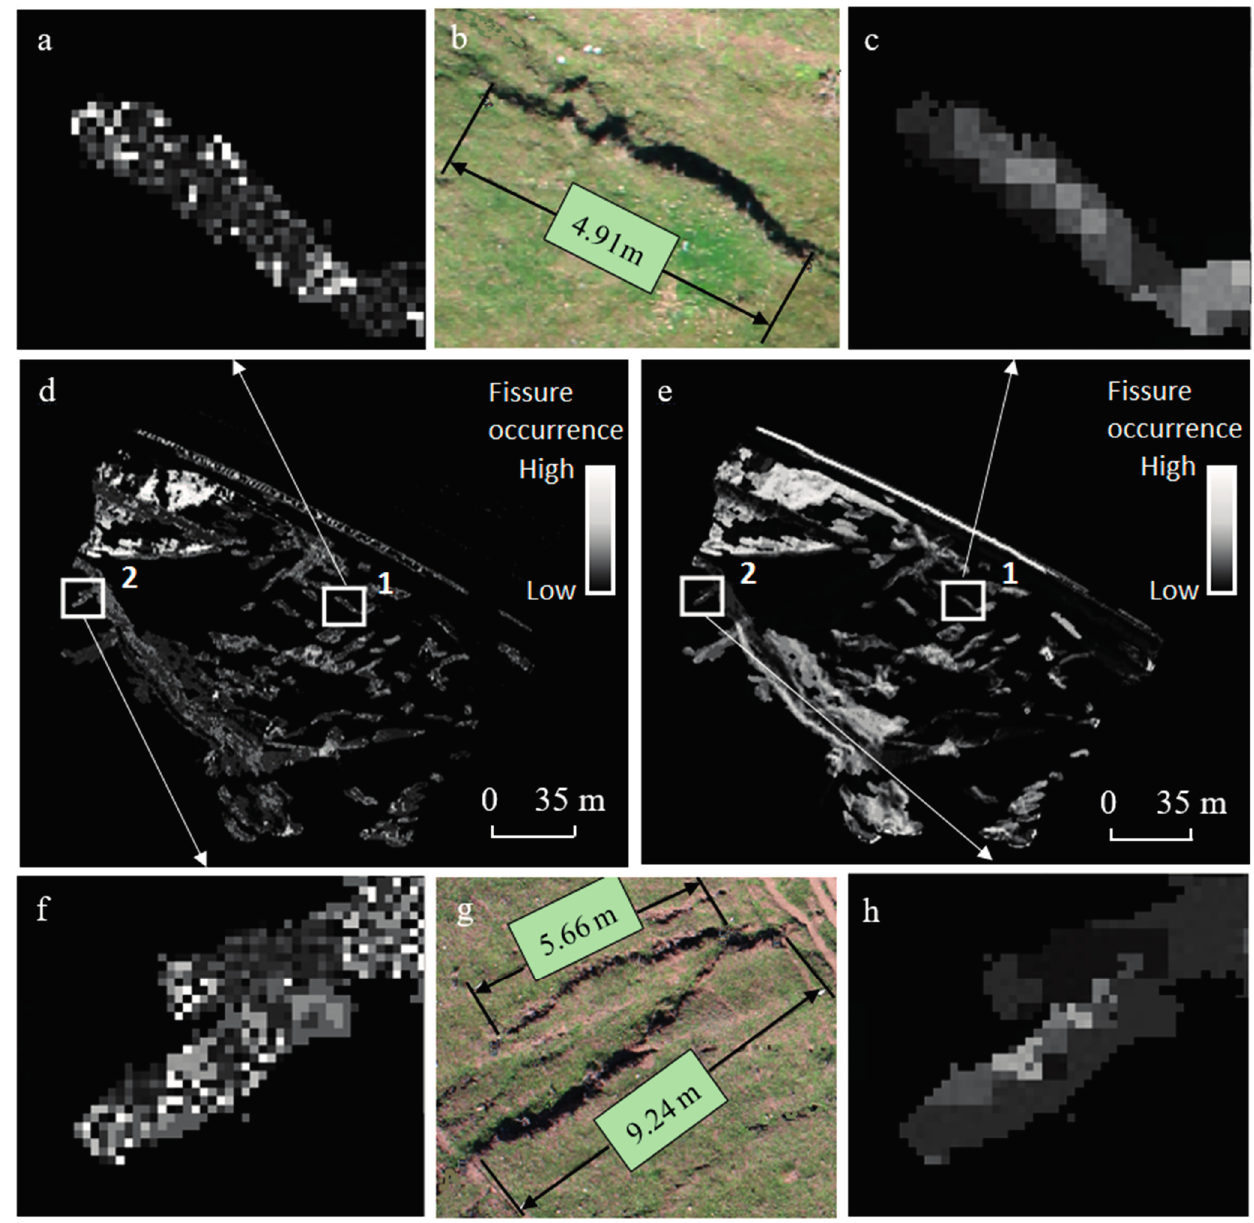
Figure 13. ( a ) Square area 1 was zoomed in ANFIS result. ( b ) The photogrammetric measurement of square area 1 on the UAS image. ( c ) Square area 1 was zoomed in LR result. ( d ) The ANFIS fissure map. ( e ) The LR fissure map LR. ( f ) Square area 2 was zoomed in ANFIS result. ( g ) The photogrammetric measurements of square area 2 on the UAS image. ( h ) Square area 2 was zoomed